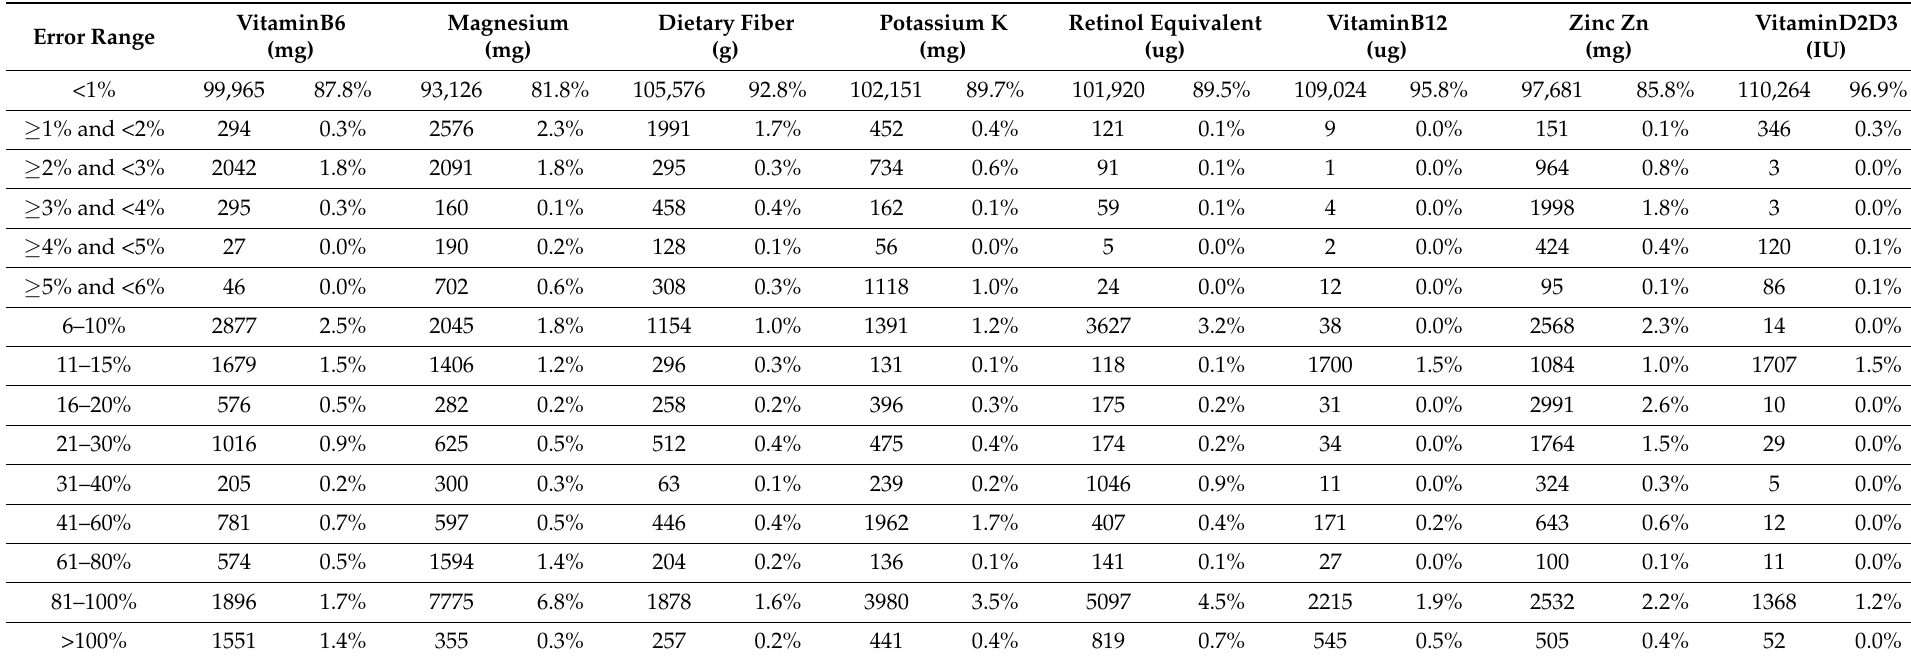
Table 6. Discrepancy comparison table of NNHS analysis with the results of this study in the food_wt_and_nutrients